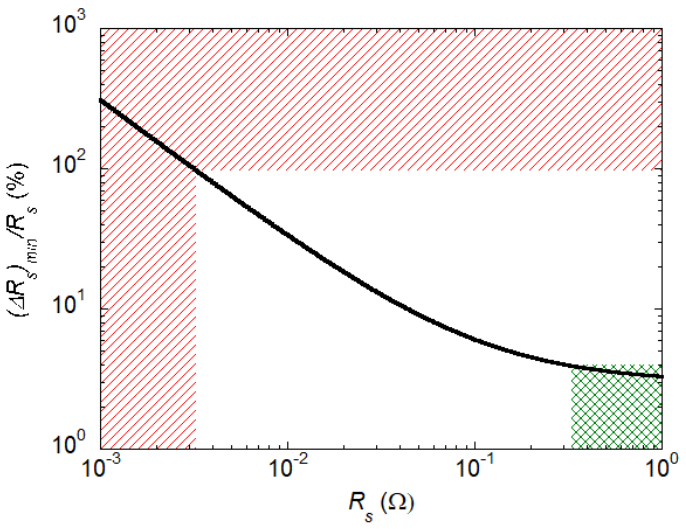
Figure 4. Percentage relative variation ( ∆ R s ) min / R s as a function of the surface resistance R s of the sample under investigation. The upper area where the DR is not sensitive to R q variation is marked with red oblique lines, while the bottom right green marked area is where ( ∆ R s ) min / R s <